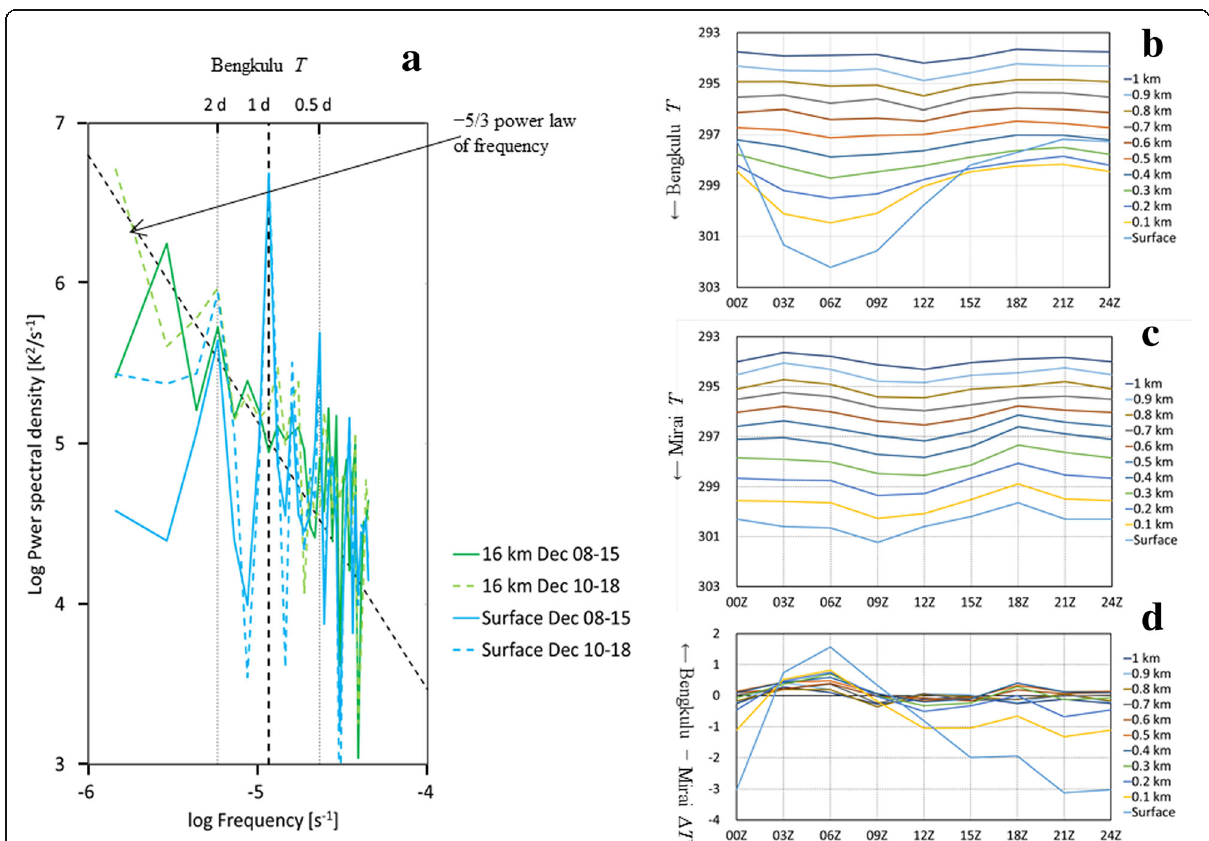
Fig. 9 Examples of a frequency power spectra (at a coastal land station in Bengkulu (04°S, 102°E), southwestern coast of Sumatera); b , c 10 day- mean land (Bengkulu)/marine (RV Mirai, approximately 50 km SW from Bengkulu) atmospheric temperature diurnal cycles below 1 km altitude; and d their difference, obtained during 8 – 18 December 2015. The abscissas of b − d are in UT (= LT − 7 h). Details of the observations are described in Yokoi et al. (2017) and Wu et al.